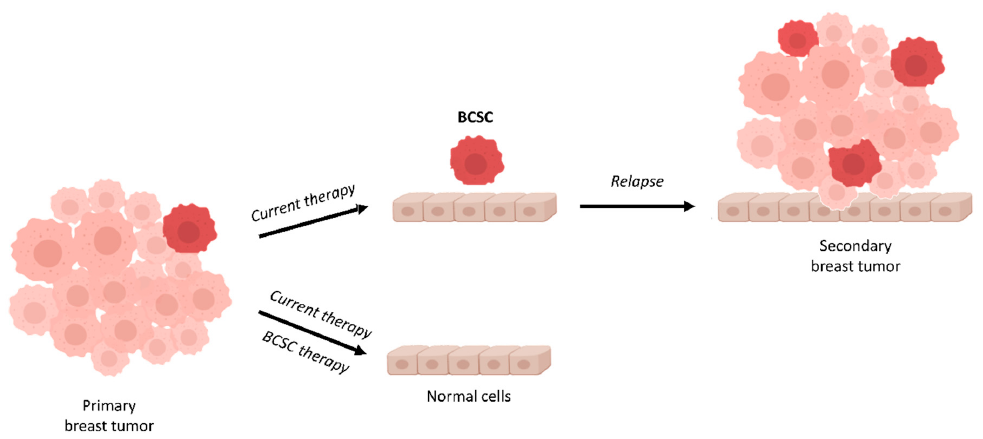
Figure 1. Schematic representation of tumor cell heterogeneity in an aggressive breast cancer. The primary tumor is formed of heterogeneous subpopulations of cells including breast cancer stem